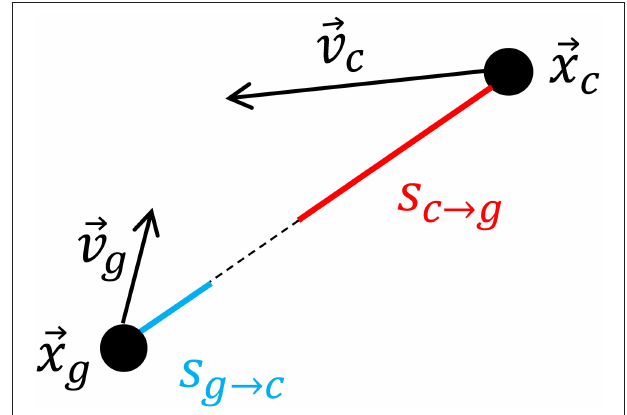
FIGURE 1 | Schematic showing how the velocities of the caller toward the group centroid s c → g and group centroid toward the caller s g → c are calculated according to the positions of the group centroid (x g ) and caller (x c ) and the velocities of the group centroid (v g ) and caller (v g ) at each